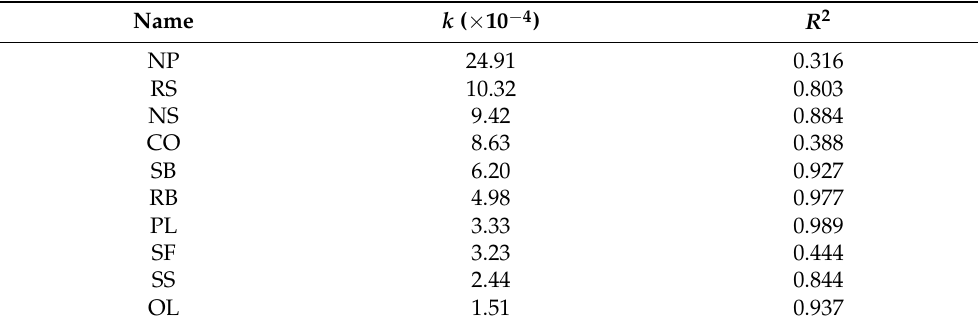
Table 4. Linear fitting results of change in the peak area of pentanal (Sp) with change in carbonyl value (CV) of 10 types of oil during frying with k calculated using Equation